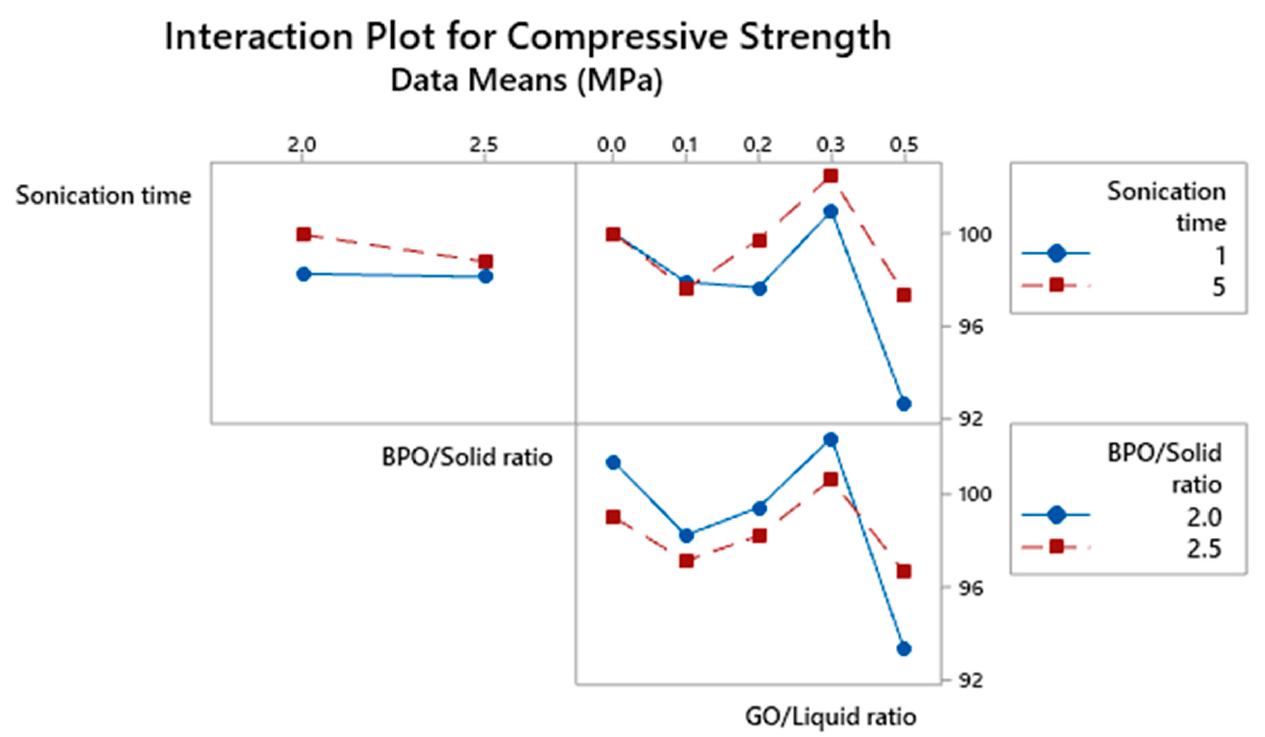
Figure 6. Interaction plot between the effect sonication time, GO/liquid ratio, and BPO/solid ratio for the variable compressive strength.